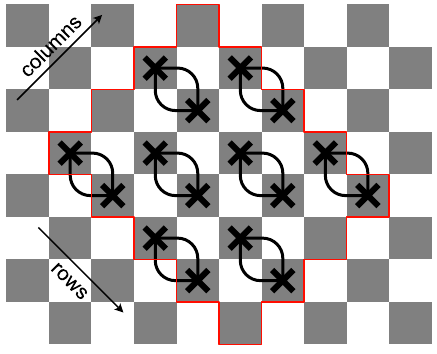
FIG. 11. On a rotated L 1 × L 2 grid (here, 4 × 5), we can imple- ment an odd-even pattern of swap gates on data qubits (gray) using ancillae (white). Row-wise and columnwise SWAP gates used in SWAP routing on a grid [21] can be modified as shown above so that the ancillae used for SWAP gates do not